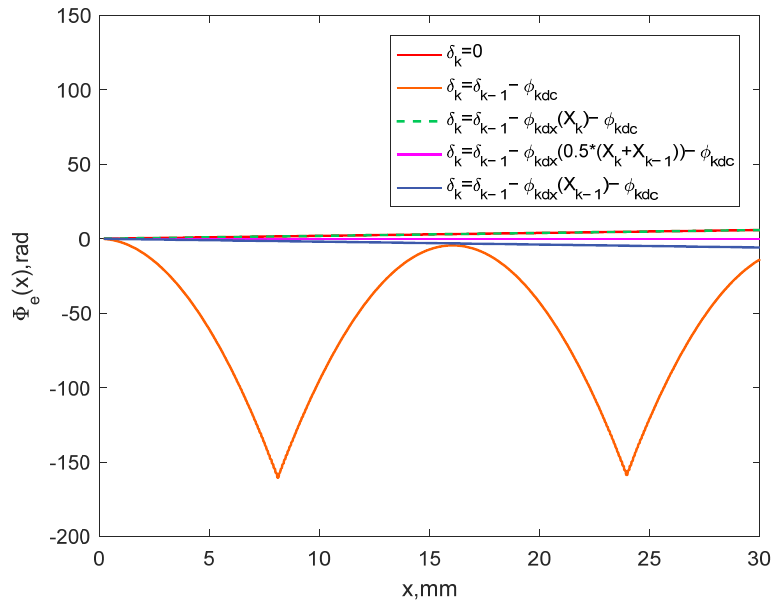
Figure 7. Phase error under the condition of f k = g ( X k ) and S k = N steps / f k − 1 with different δ k .